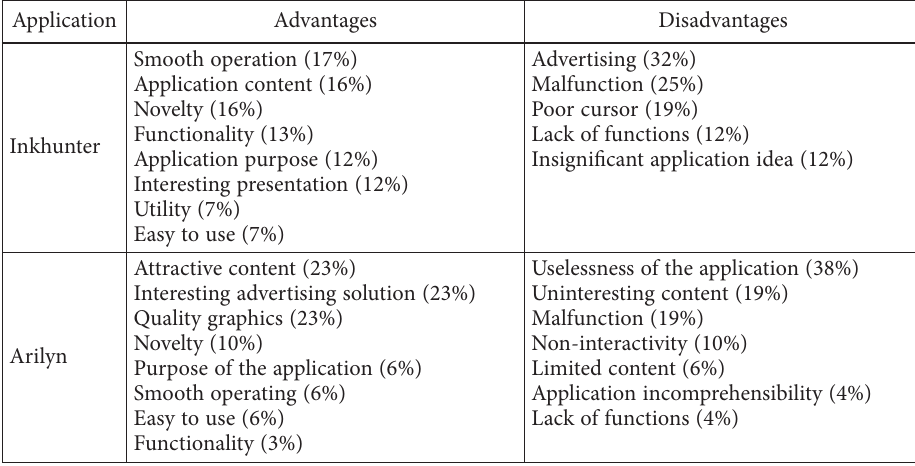
Table 5. The advantages and disadvantages of augmented reality applications Inkhunter and Arilyn (source: created by the